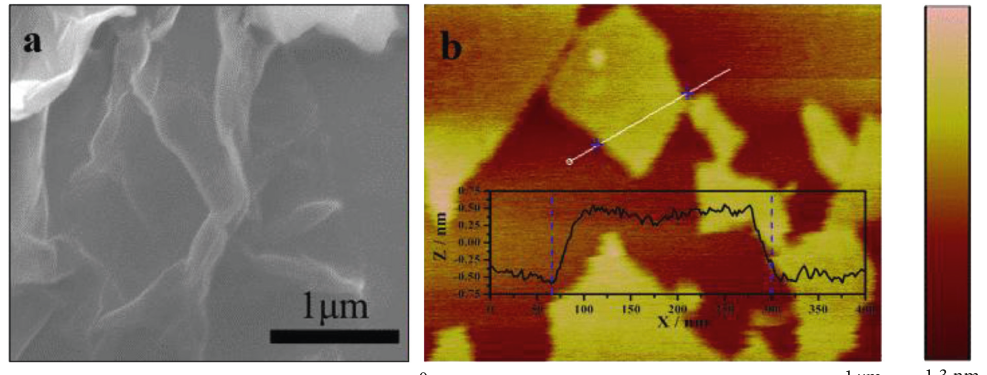
Figure 2: SEM (a) and AFM (b) images of GO.